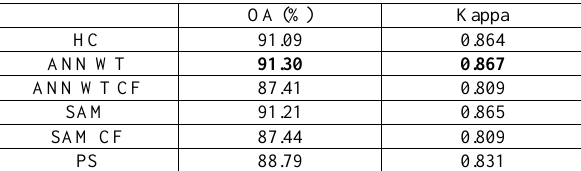
Table 2. Accuracy assessment of sub-pixel mapping